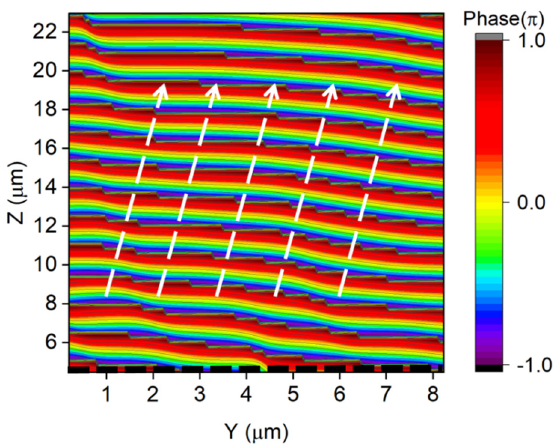
Figure 7. The isophase plane at the transmissive end of the metasurface array under the incident x-line polarized light, with white arrows in the direction of the isophase plane vertical line, a black dashed line being the light-emitting surface of the metasurface, and different color stratifications representing different isophase planes.